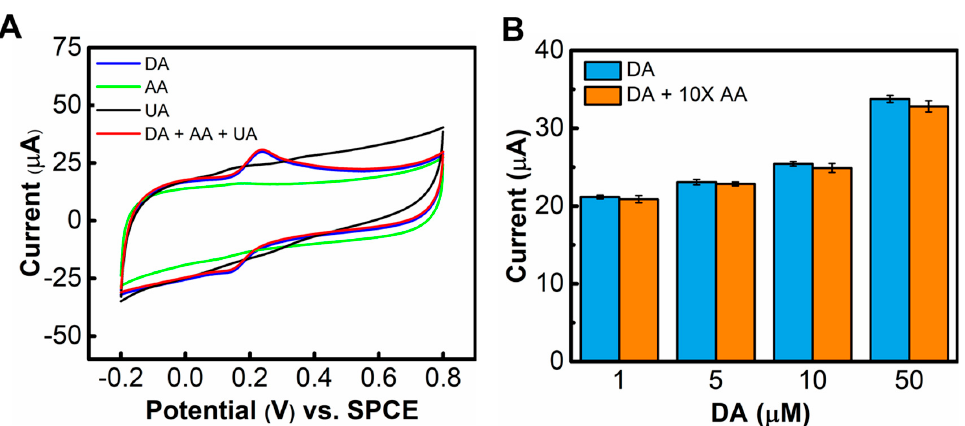
Figure 4. ( A ) CV curves of tyrosinase/chitosan/rGO/SPCE in the presence of 100 μ M AA, UA, DA and the mixture of the three. ( B ) Peak oxidation current levels of DA in presence/absence of a 10-fold higher concentration of AA. Error bars represent the standard deviation from triplicate measurements.